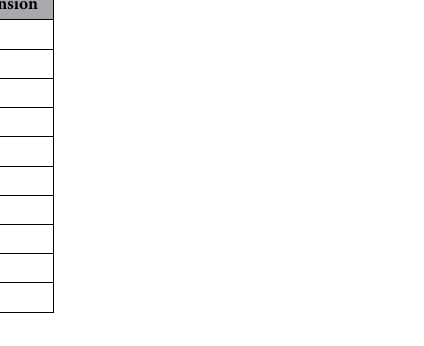
Table 1. Extracted features from protein